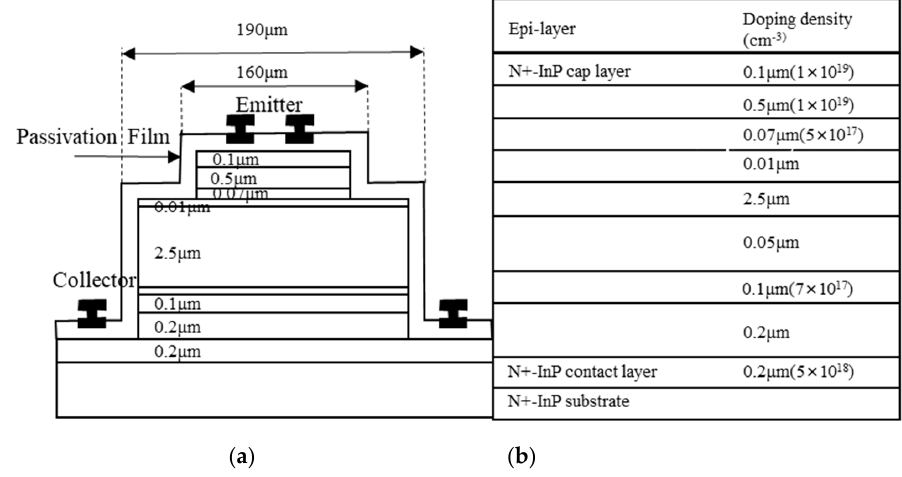
Figure 48. ( a ) The cross-section schematic diagram of APTs and structure profiles, ( b ) bandwidth and response time curves as a function of gain